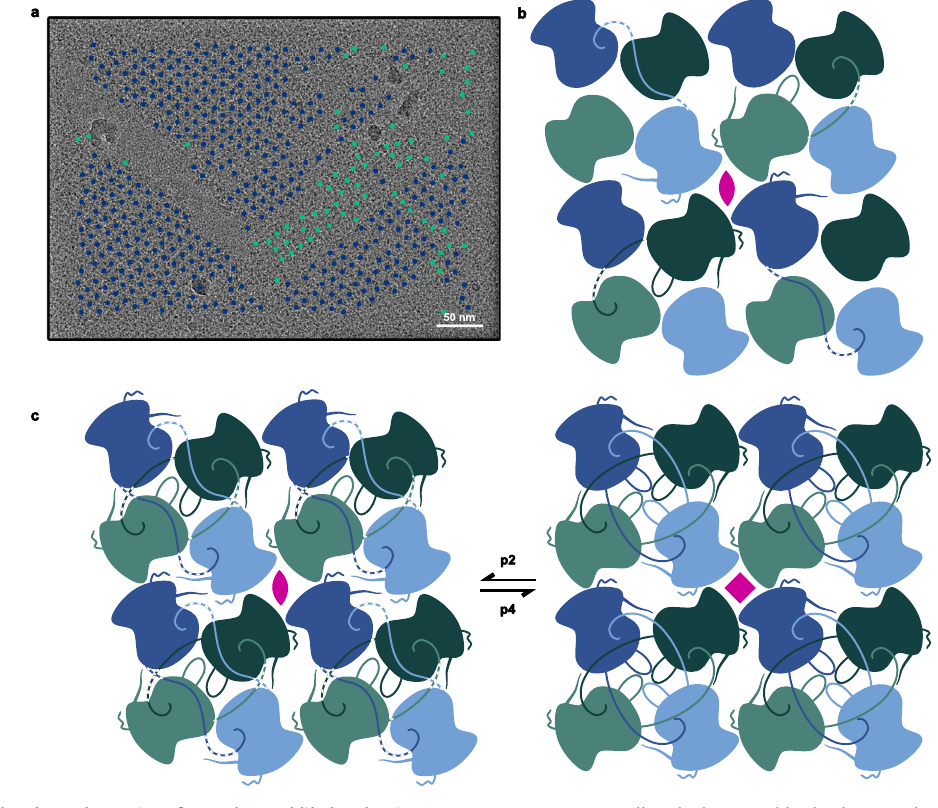
Fig. 6 | PhuN assembles through a series of complex and likely adaptive C-terminaltailexchangesexhibitingbothp2andp4symmetries.a Micrograph of in vitro assembled PhuN lattices with the p2 (blue) and p4 (green) particles displayed. ( n =8). b Cartoon showing core tetramer with N- and C-terminal tail